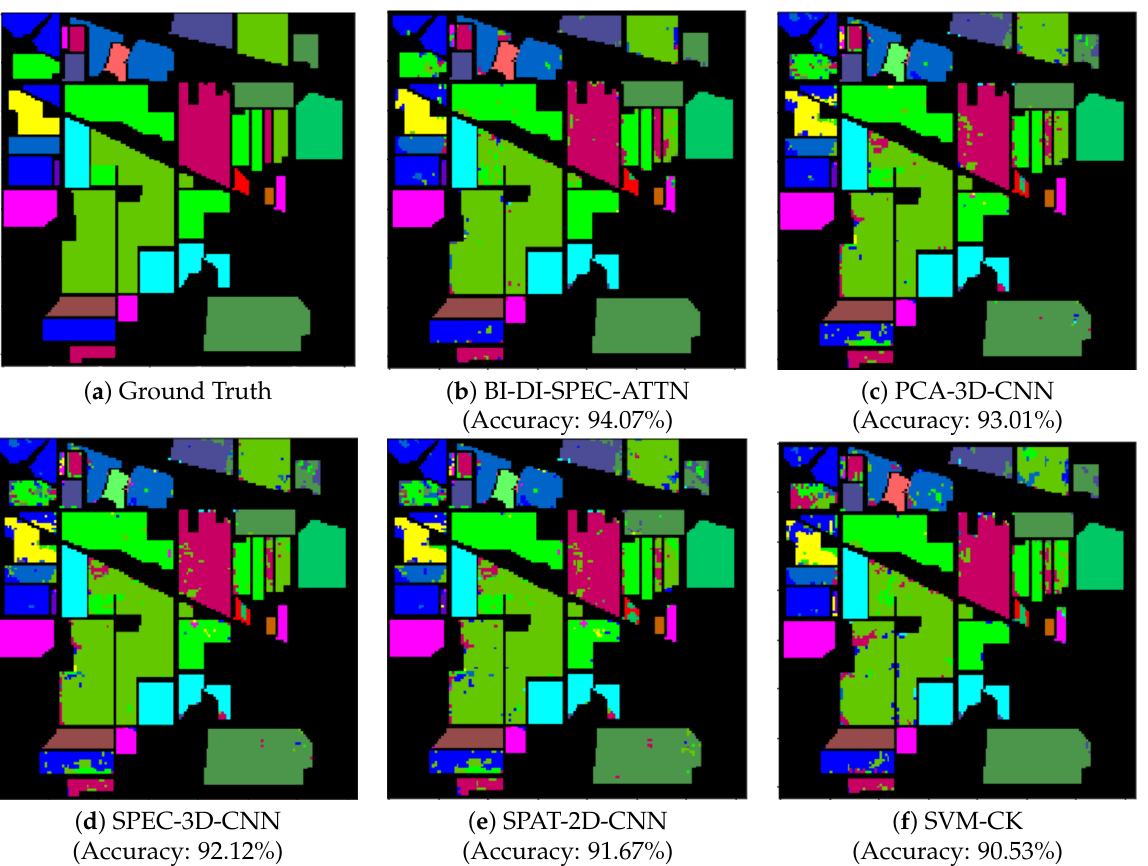
Figure 3. Classification maps of Indian Pines dataset for all proposed methodologies using 10% of training